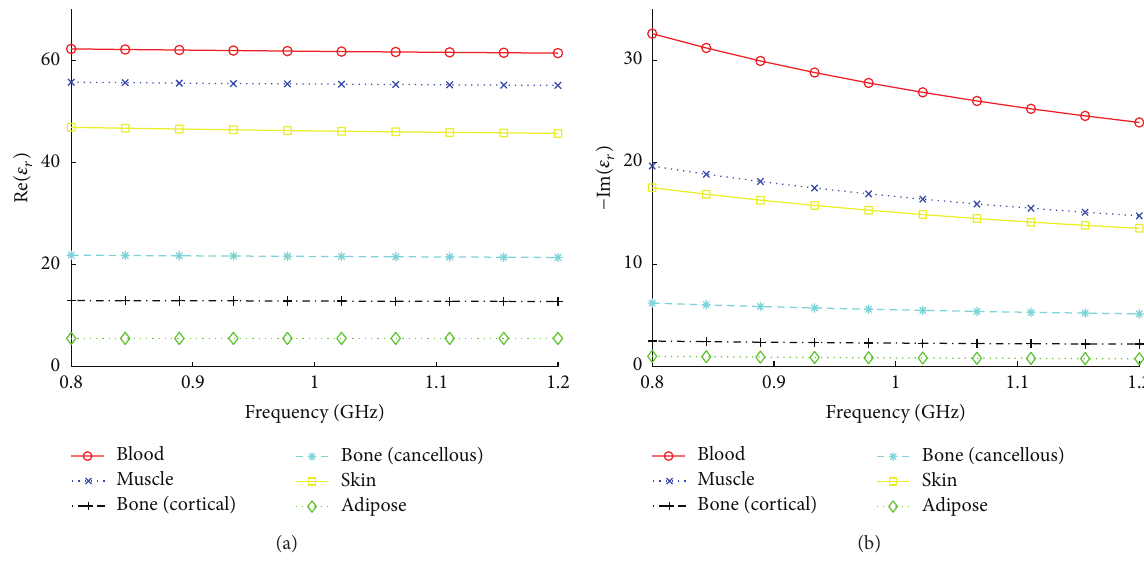
Figure 9: Relative permittivities of various human tissues from 0.8 to 1.2GHz using the model in [15]. Table 3: Measured results from MRI images and estimates of lowest/highest relative permittivities from MWI in the muscle region at 1GHz. MRI MWI Max.